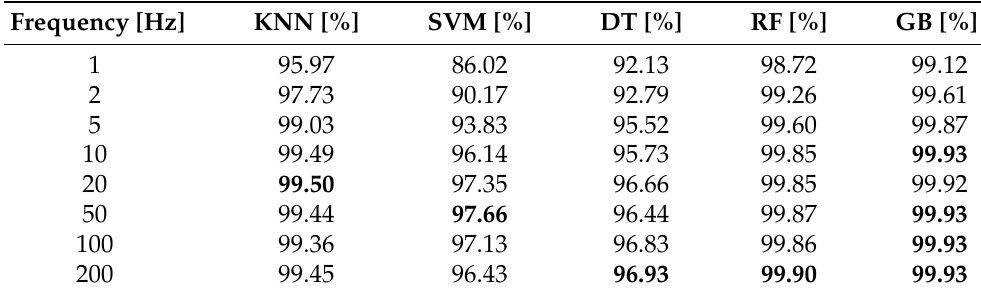
Table 9. Comparison of the AUROC across the ML algorithms, with the highest values in